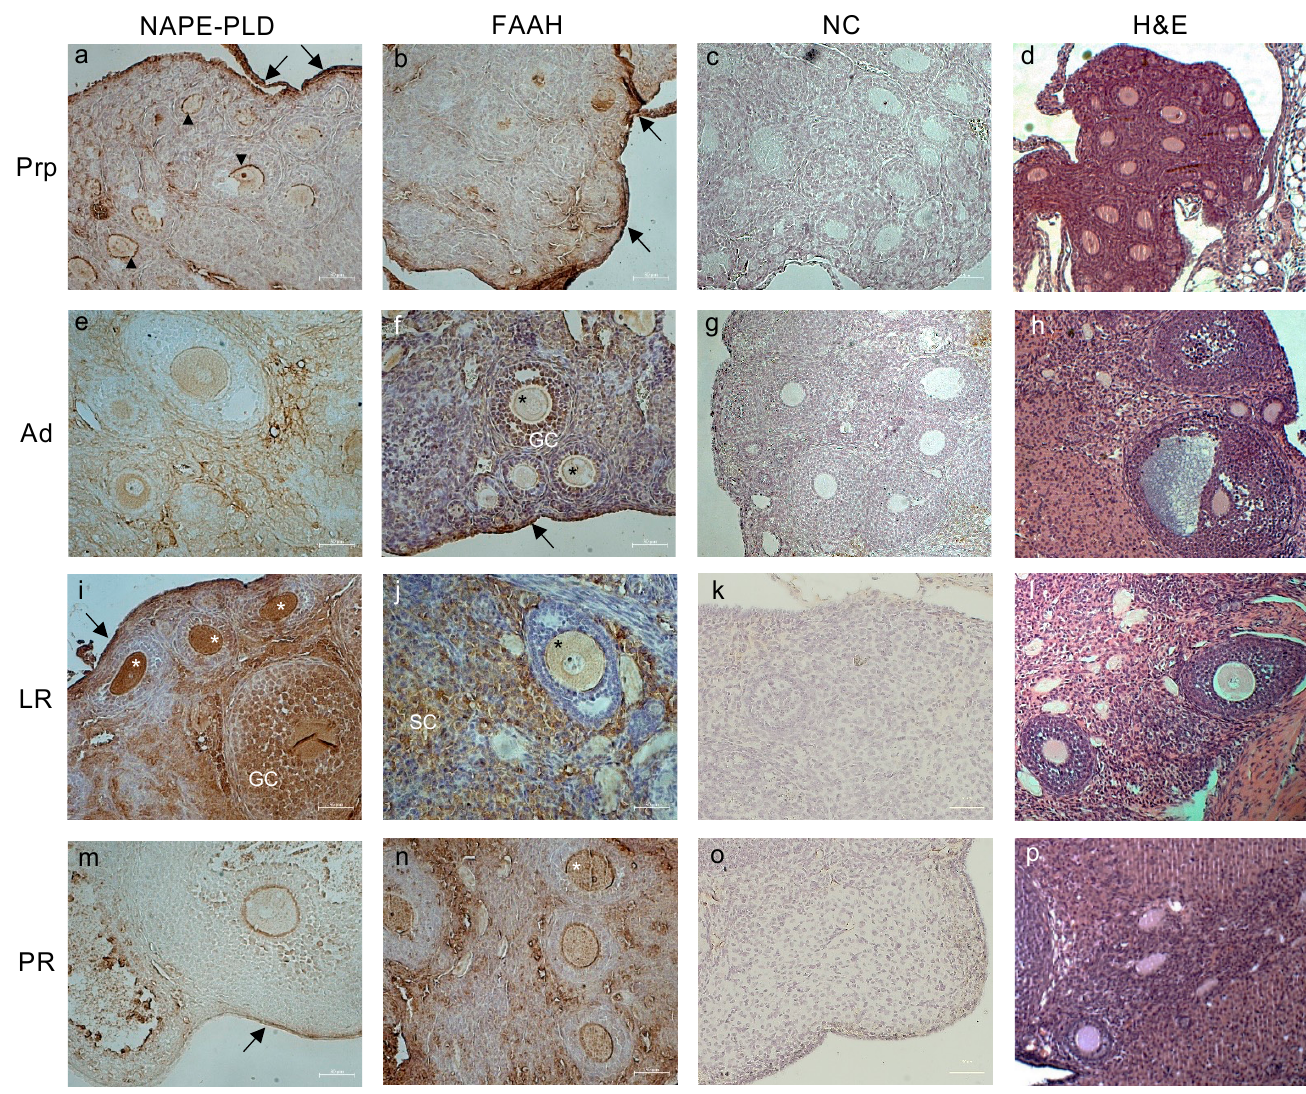
Figure 2. Representative images of tissue localization of NAPE-PLD and FAAH in mice ovaries during reproductive aging. Representative images of NAPE-PLD ( a , e , i , m ) and FAAH ( b , f , j , n ) im- munoreactivity in prepubertal (PrP), adult (Ad), late reproductive (LR), and post-reproductive (PR) mouse ovaries. Negative controls (NC; c , g , k , o ) and H&E staining ( d , h , l , p ) are also presented. An- notations and abbreviations—Arrows: ovarian surface epithelium; arrowheads: interstice granulosa cells–oocyte; asterisks: oocytes; GC: granulosa cells; SC: stroma cells. Scale bar: 50 µ m. Magnification: ×